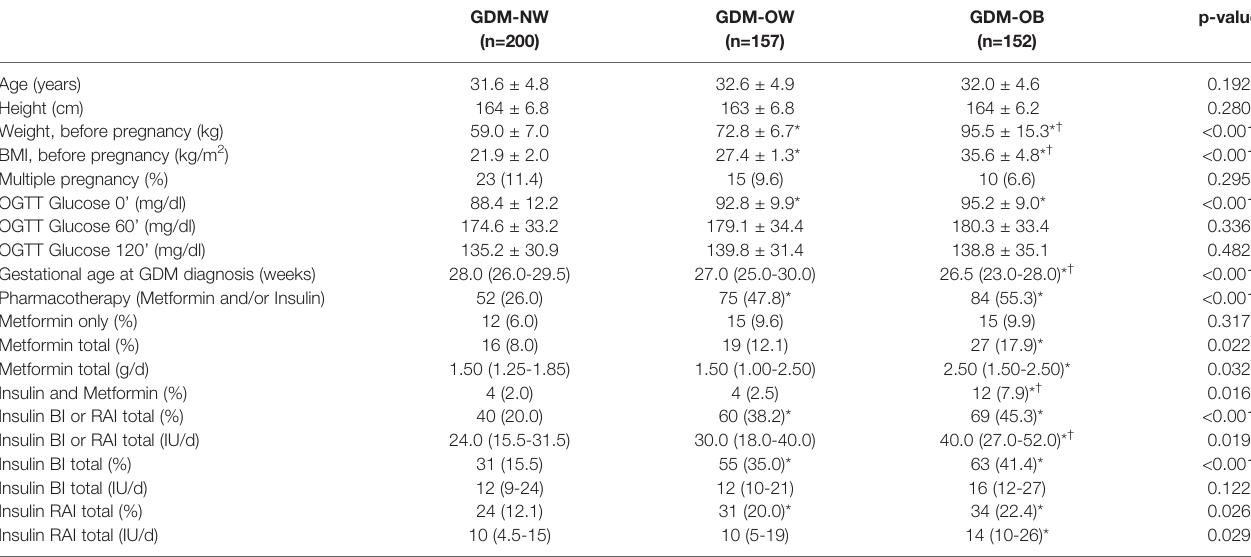
TABLE 1 | Characteristics of the study